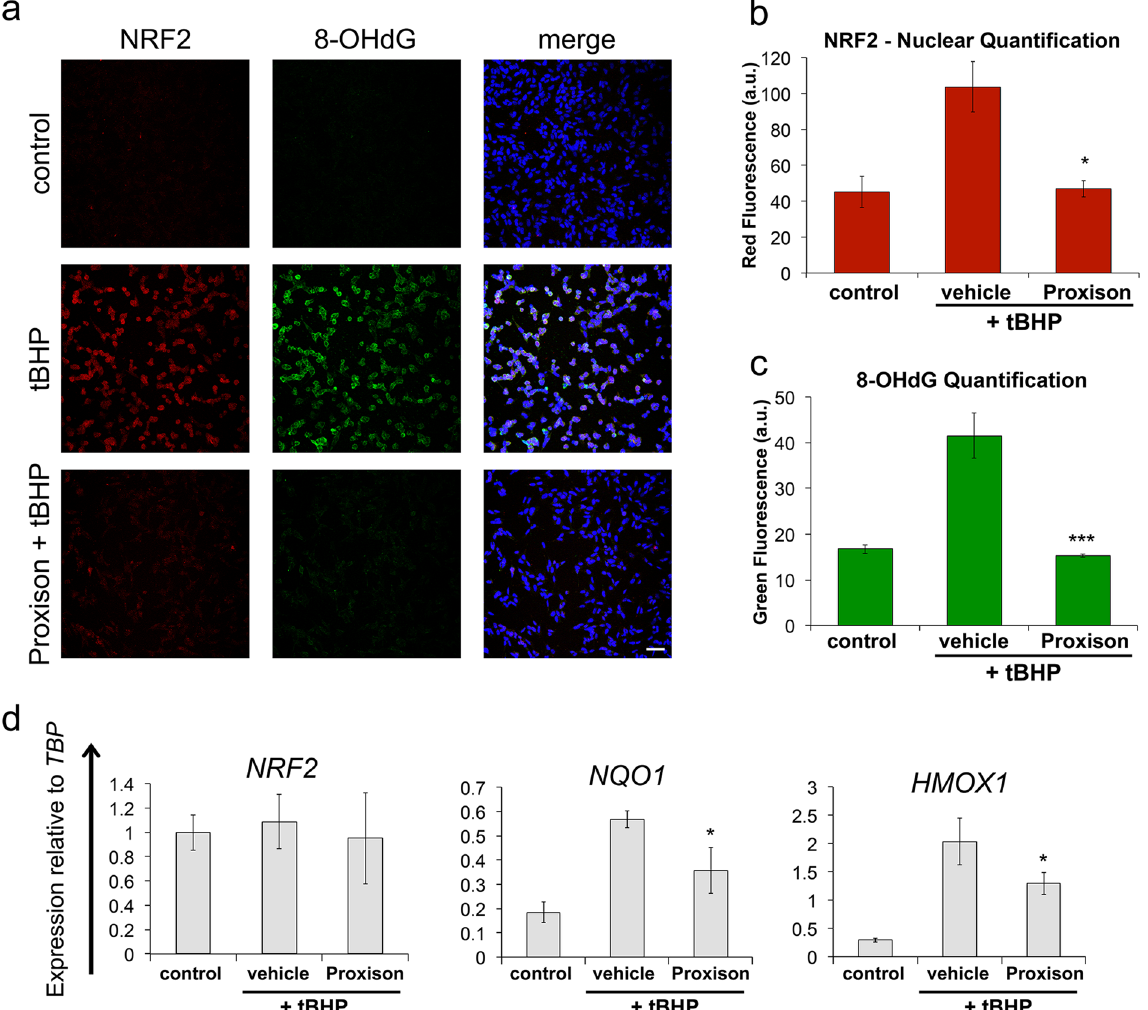
Figure 5. Proxison reduces t BHP-induced NRF2 oxidative stress response and prevents 8-OHdG DNA oxidative damage. ( a ) t BHP-treated SH-SY5Y cells in the absence or presence of Proxison were fixed and immunostained for NRF2 (red), 8-OHdG (green), and counterstained for the nuclear marker DAPI (blue). Scale bar: 60 μ m. ( b , c ) The intensity of NRF2 red fluorescence ( b ) and 8-OHdG green fluorescence ( c ) in the nuclei as quantified using ImageJ. Bars in ( b ) and ( c ) represent the mean of three coverslips from independent experiments (n = 3) with 2–4 images per coverslip, error bars represent the SEM. ( d ) RNA was extracted from similarly treated cells to measure gene expression of NRF2 , NQO1 and HMOX1 relative to TATA- binding protein ( TBP ). Bars represent the mean of duplicate or triplicate wells (n = 2–3). Error bars represent the standard deviation. ANOVA with the Tukey’s post-hoc test was performed in ( b ), ( c ) and ( d ) to assess significant difference to vehicle-treated cells; * p < 0.05, *** p <